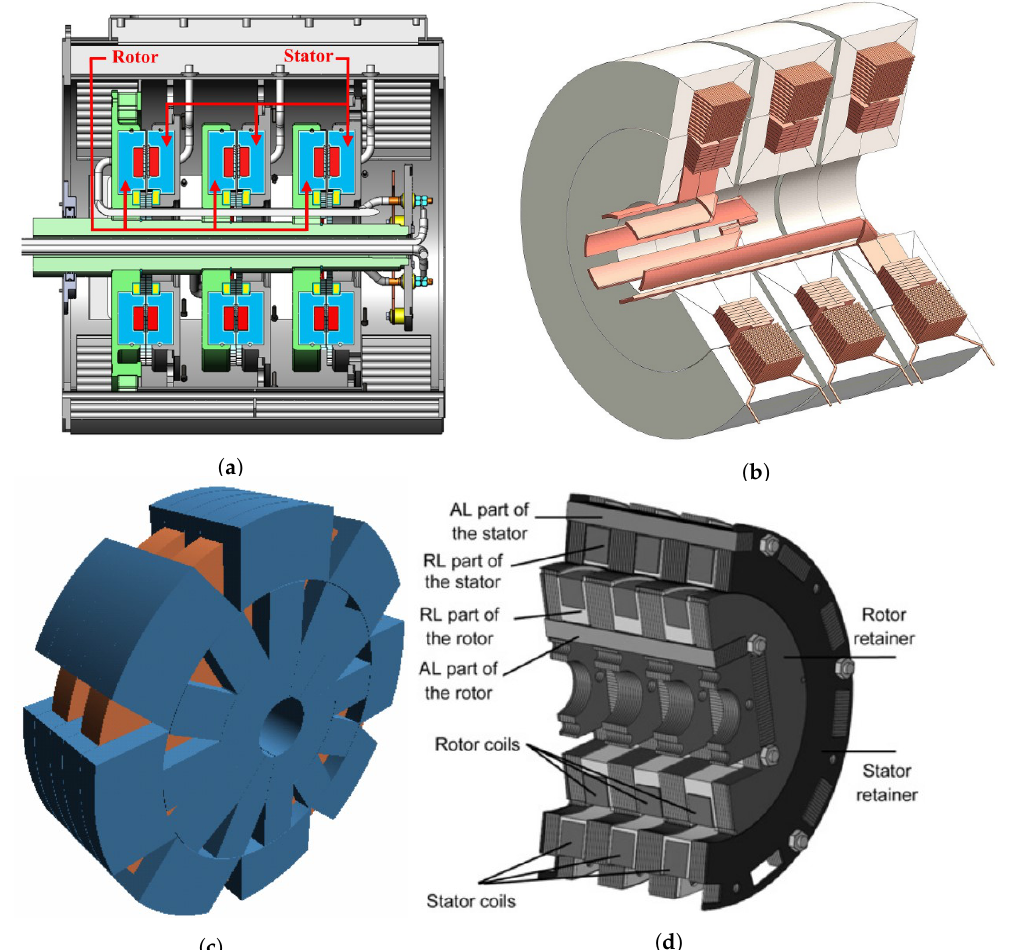
Figure 2. Three-phase axial rotary transformer topologies: ( a ) radially stacked [8], ( b ) stacked and rolled [28], ( c ) axially sliced and placed around radially [18] and ( d ) flat-plane stacked